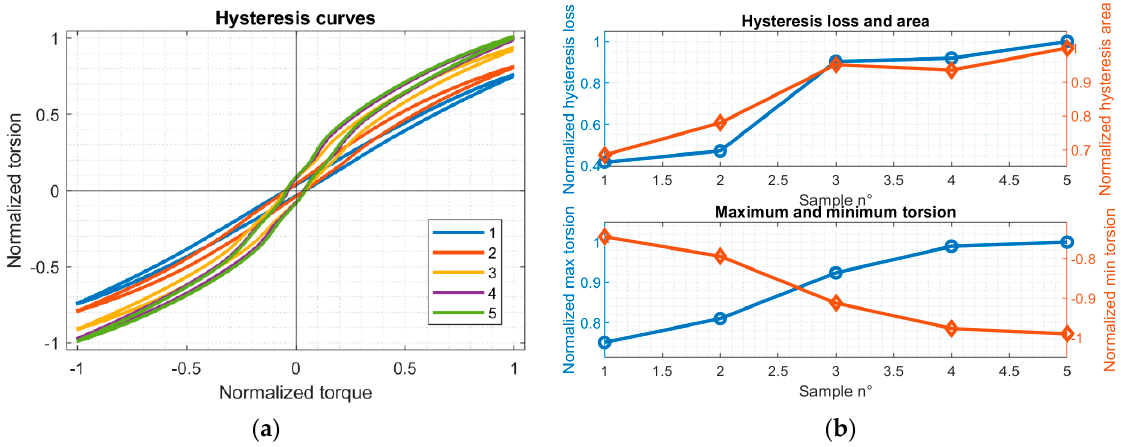
Figure 6. ( a ) Evolution of the hysteresis curve of gear A over time normalized with respect to the measurements in sample 5. ( b ) Trends of the hysteresis loss, area, and minimum and maximum torsion of gear A over time normalized with respect to the measurements in sample 5.